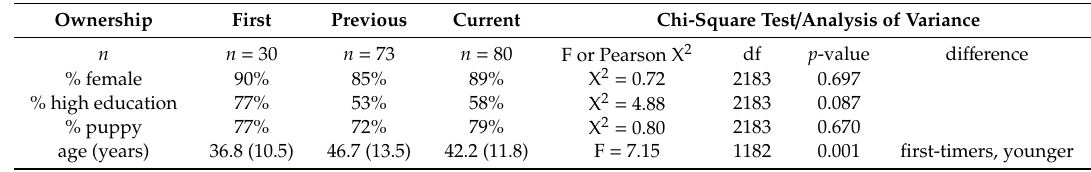
Table 1. Group di ff erences according to experience with